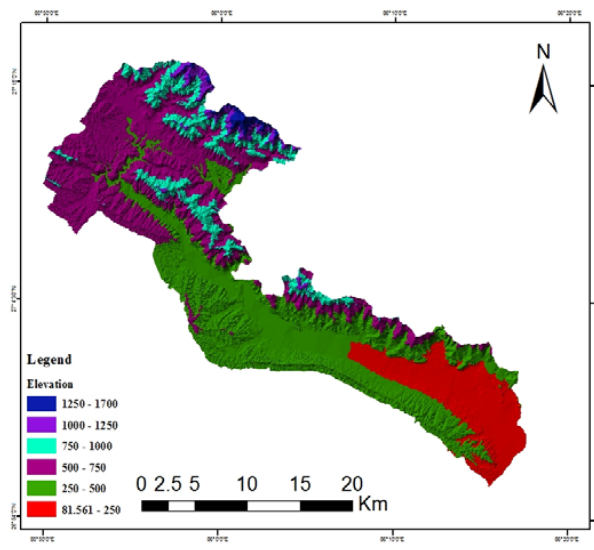
Figure 1. Map of study area. Figure 1 . Map of study area. Figure 1 . Map of study area.